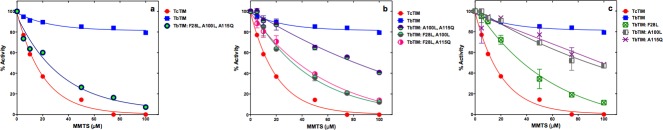
Effect of MMTS on WT TbTIM, WT TcTIM and on different site directed mutants of selected amino acids of regions 1 and 4 on the sequence of WT TbTIM.Enzymes were incubated at a concentration of 250 μg/mL in 100 mM TEA, 10 mM EDTA pH 7.4 and 5–100 μM MMTS for 2 h at 25°C. At that time, the activity of the samples was determined, including a sample without MMTS to calculate the percentage of remaining activity. Panel a) effect of MMTS on WT TcTIM, WT TbTIM and TbTIM: F28L, A100L, A115Q. Panel b) effect of MMTS on WT TcTIM, WT TbTIM and TbTIM: A100L, A115Q, TbTIM: F28L, A100L and TbTIM: F28L, A115Q. Panel c) effect of MMTS on WT TcTIM, WT TbTIM and TbTIM: F28L, TbTIM: A100L and TbTIM: A115Q. Assays were performed independently three times.